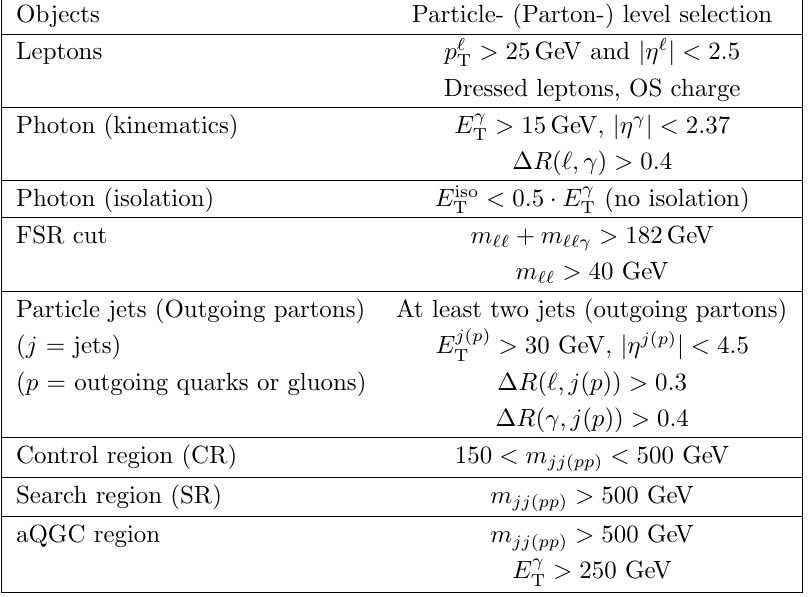
Table 5 . Charged-lepton channel phase-space region de(cid:12)nitions at particle level (parton level when di(cid:11)erent) for both pp ! Z(cid:13)jj EWK and QCD production. If there are more than two jets/(cid:12)nal- state partons, the two highest transverse momentum ones are